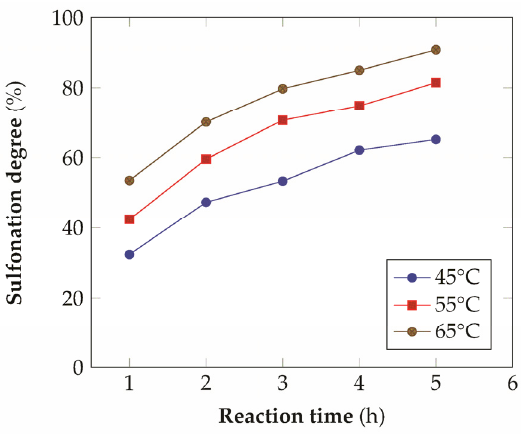
Figure 2. Degree of sulfonation of PEEK in concentrated H 2 SO 4 as a function of time and temperature (onset of the time scale is from the complete dissolution of the polymer in acid).